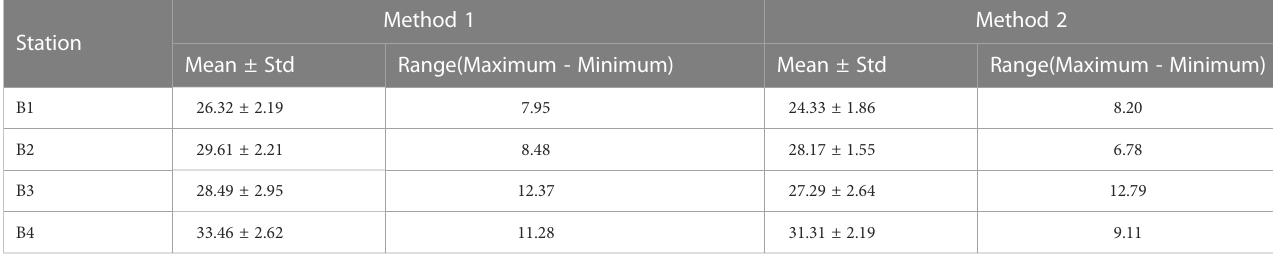
TABLE 2 The mean and range of seasonal amplitude of velocity (unit: cm s -1 ).